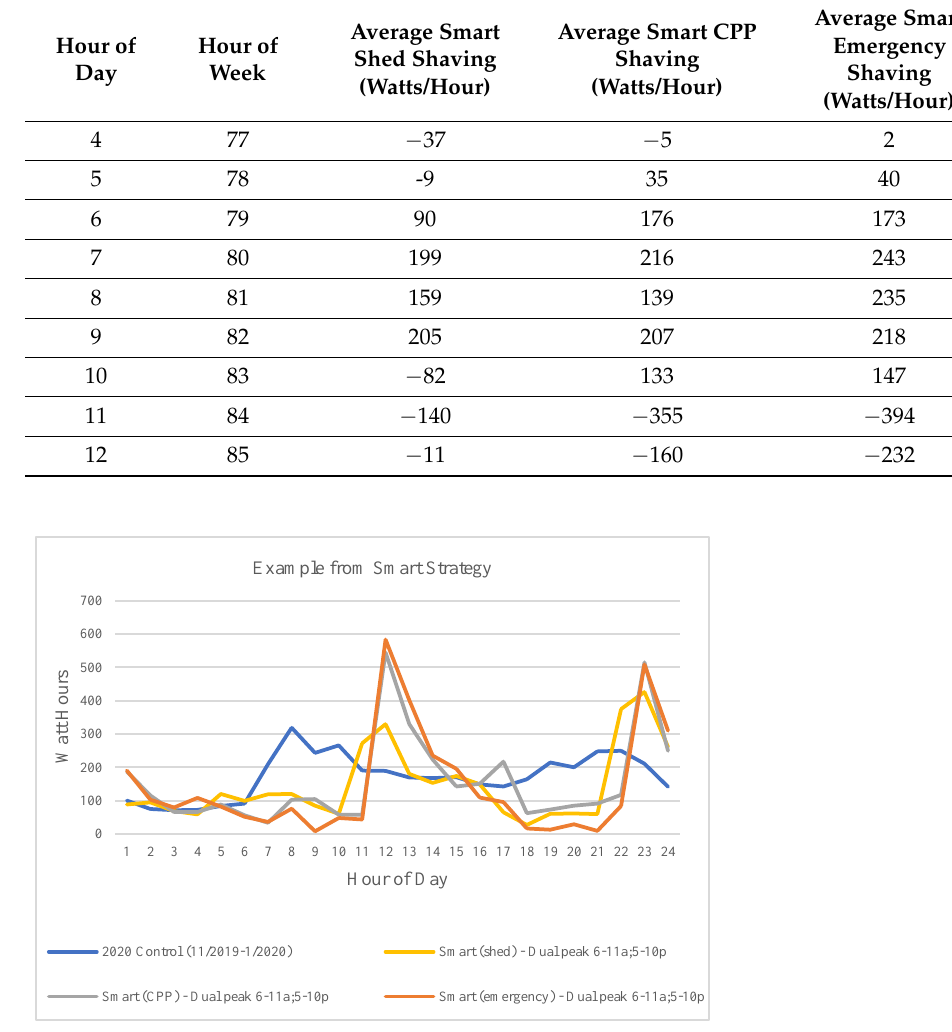
Figure 5. Example power profile from smart strategy. Table 8. Morning Energy Shifted.